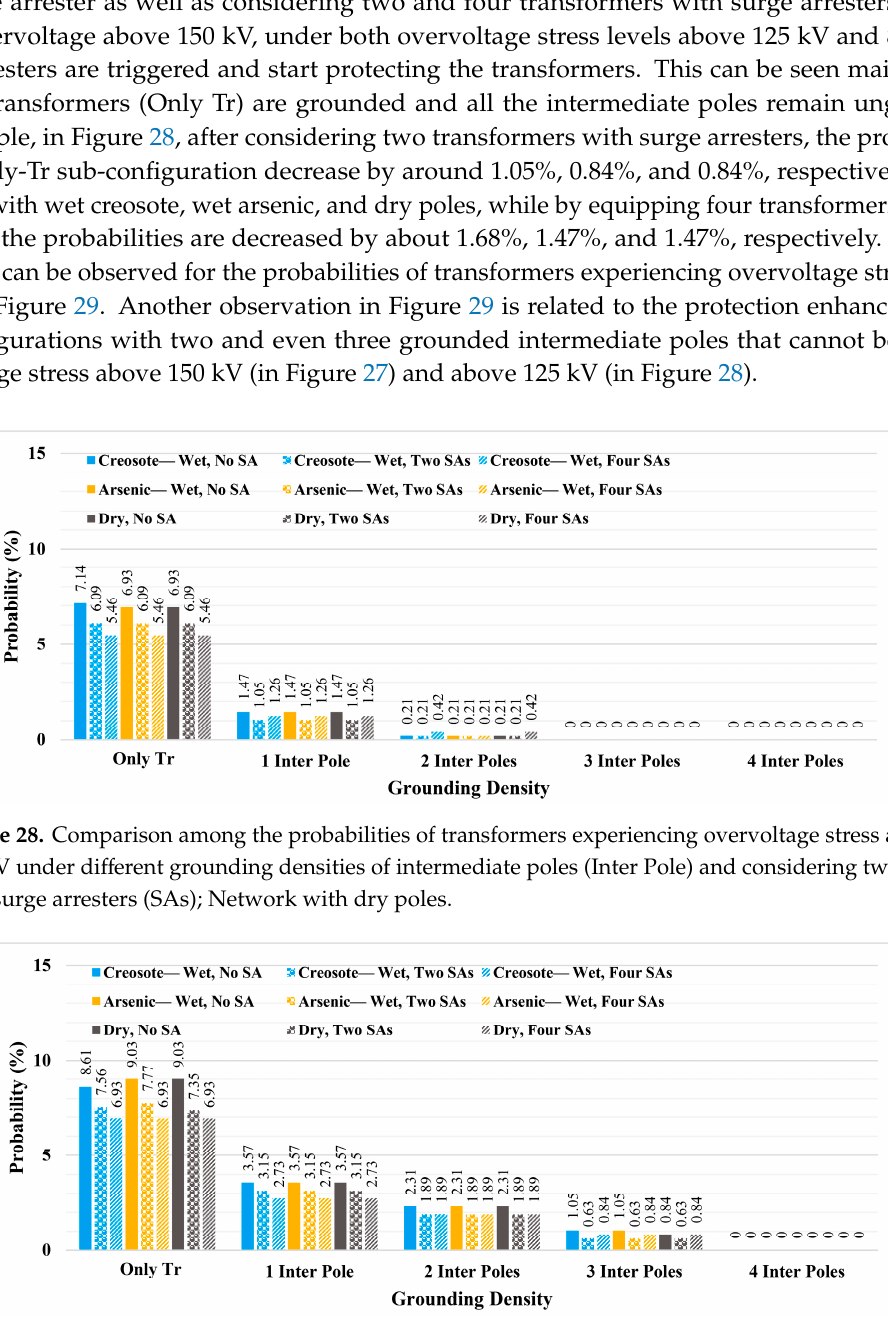
Figure 29. Comparison among the probabilities of transformers experiencing overvoltage stress above 85 kV under different grounding densities of intermediate poles (Inter Pole) and considering two and four surge arresters (SAs); Network with dry poles.